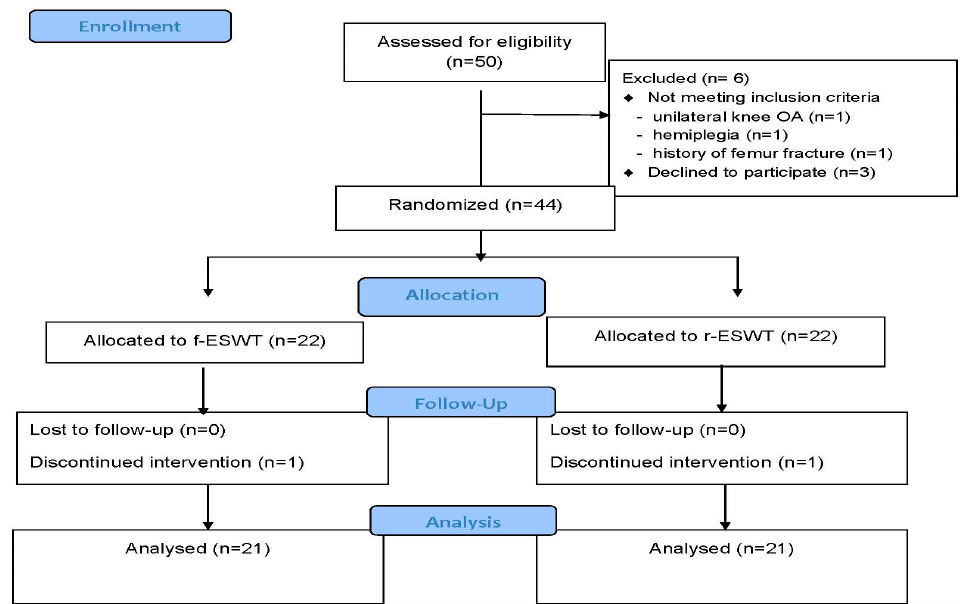
Figure 1. Flow diagram of patients included in the study.